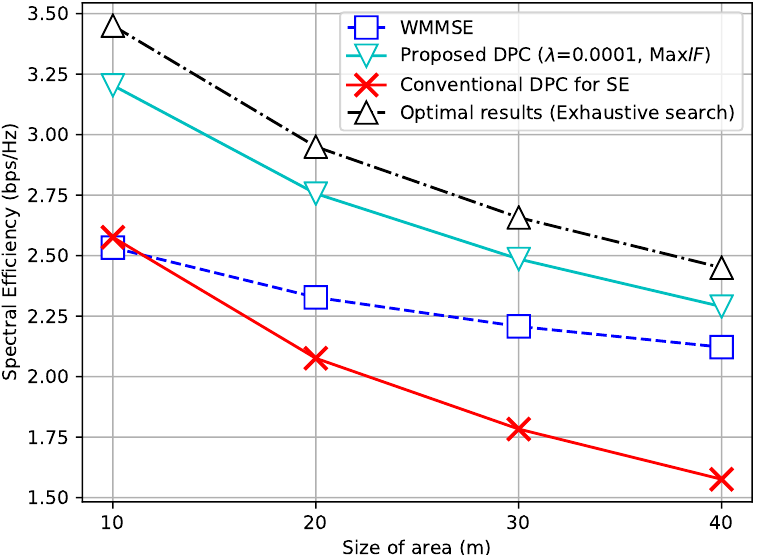
Figure 9. Average spectral efficiency of the conventional and proposed schemes for α = 5 in Rayleigh fading